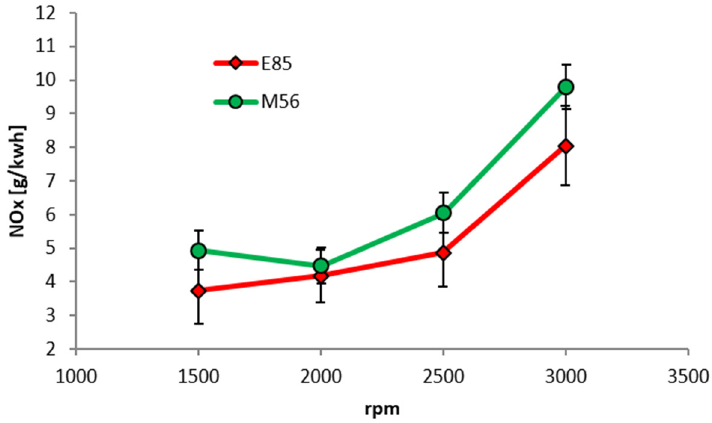
Figure 19. NOx emissions as a function of engine speed for a fixed brake torque of 75 Nm (5.29 bar BMEP).